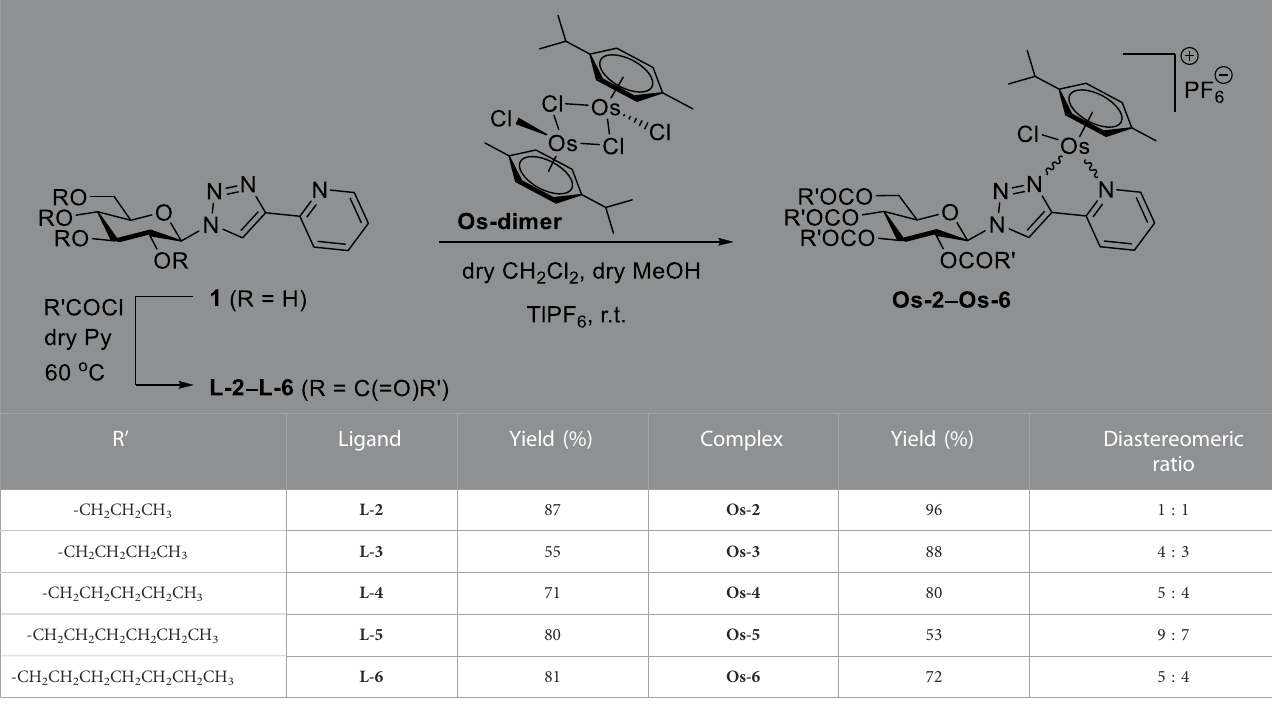
TABLE 1 Synthesis of O -peracylated 1-( β - D -glucopyranosyl)-4-(pyridin-2-yl)-1,2,3-triazoles and their [( η 6 - p -cym)Os II (N-N)Cl]PF 6 compexes.